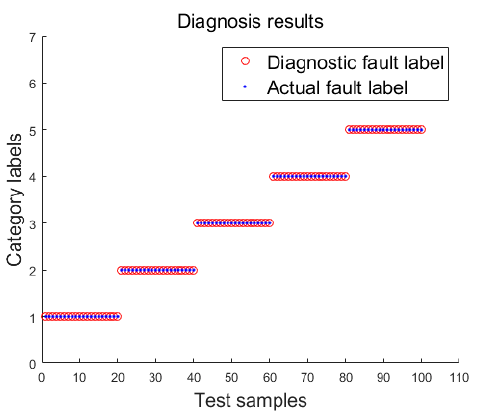
Figure 23. Classification result under condition 2.